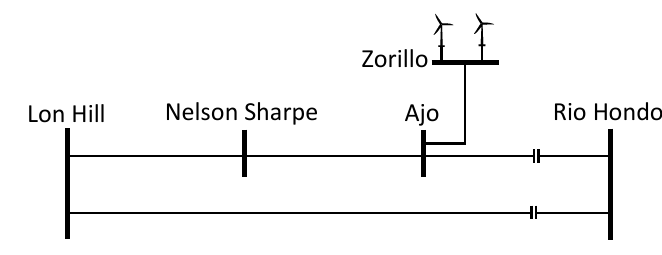
Figure 3. Single line diagram of part of the South Texas transmission system.